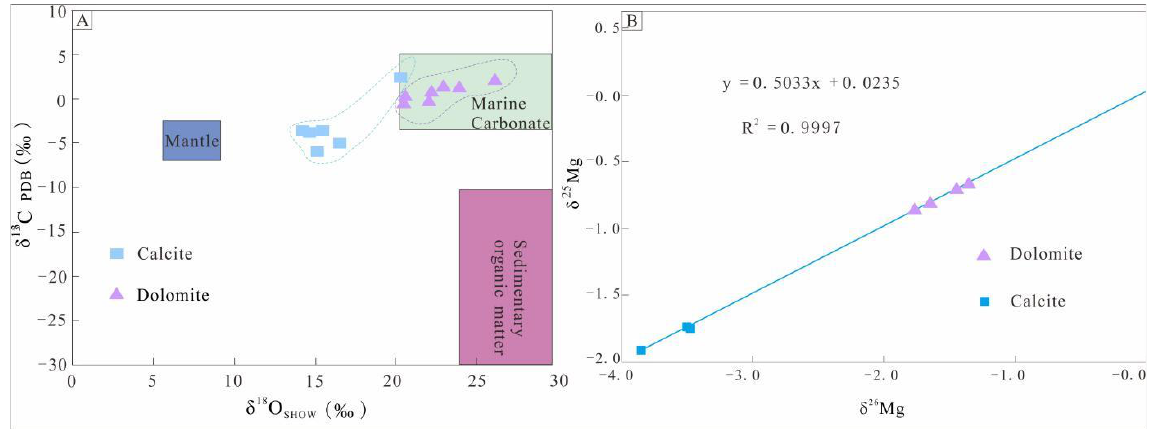
Figure 9. ( A ) Diagram of δ 13 C vs. δ 18 O of calcite and dolomite in Lekai Pb-Zn deposit (Mantle [56]; Marine Carbonate rocks [58]; Sedimentary organic matters [57]); ( B ) Diagram of δ 26 Mg vs. δ 25 Mg of calcite and dolomite in Lekai Pb-Zn deposit.